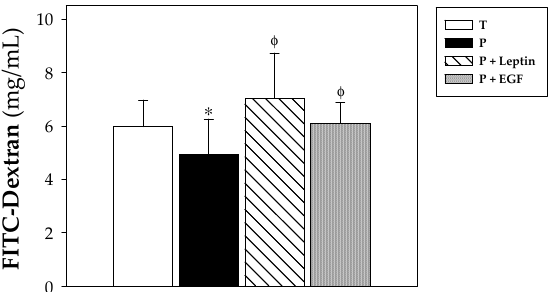
Figure 7. Intestinal permeability to 4 kDa-FITC-dextran from the four groups: Term (T), Preterm (P), P + Leptin, and P + epidermal growth factor (P + EGF) at day 10. Results are expressed as mean ± SD ( n = 9 pups/group). Statistical differences: * p < 0.05 versus T group; φ p < 0.05 versus P group.